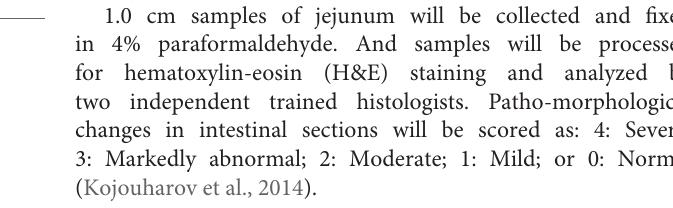
TABLE 1 | Chromatography separation program. Time (min)